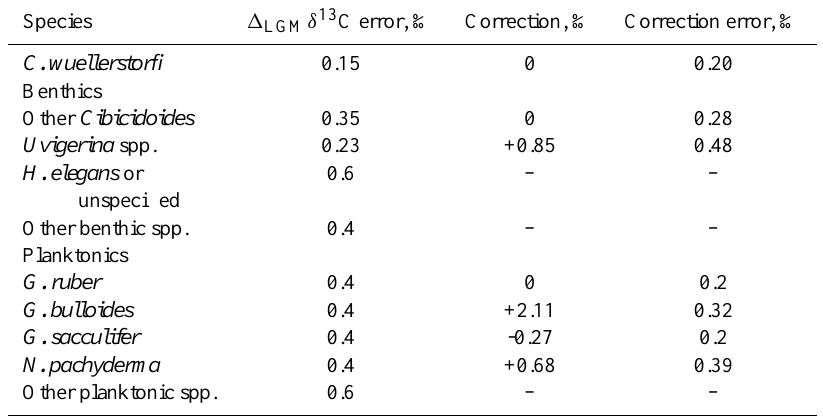
Table 2. Species-specific error estimates and uniform adjustments applied to the dataset. Correction and correction error estimates affect the calculation of δ 13 C but not 1 LGM δ 13 C; where no correction is given, no absolute δ 13 C estimate is